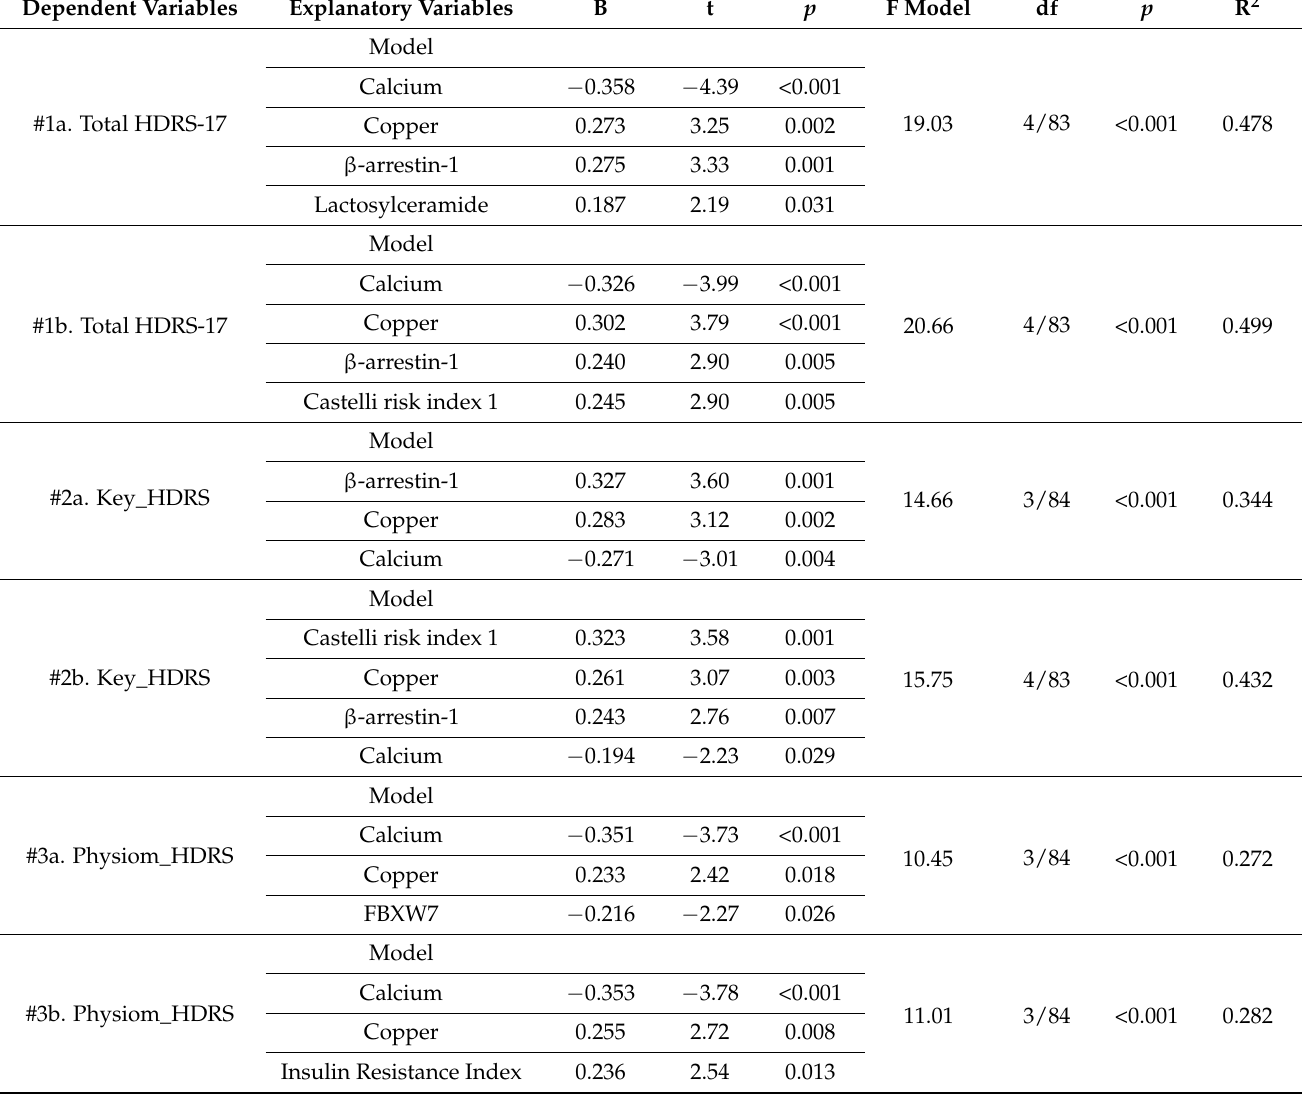
Table 3. Results of multiple regression with the Hamilton Depression Rating Scale (HDRS) scores as dependent variables and biomarkers as explanatory